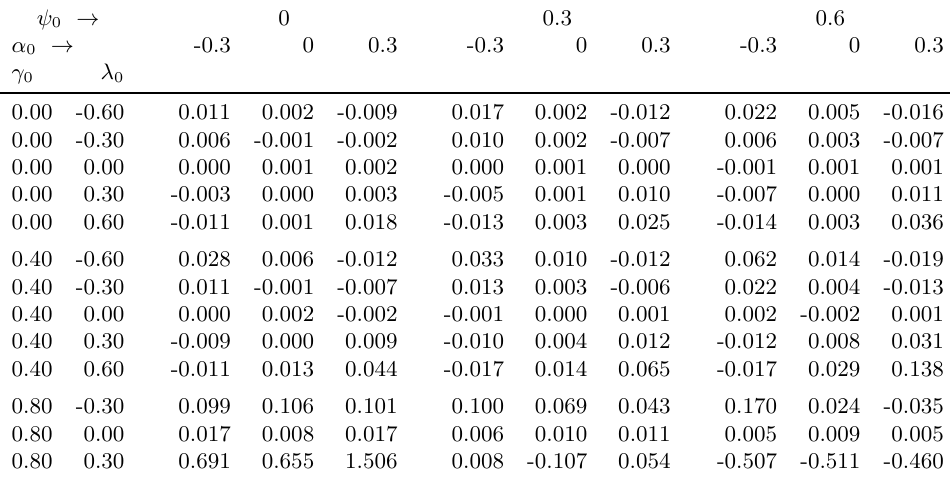
Table D.4: Bias of Team Dynamic – Long-run marginal effect of covariate.